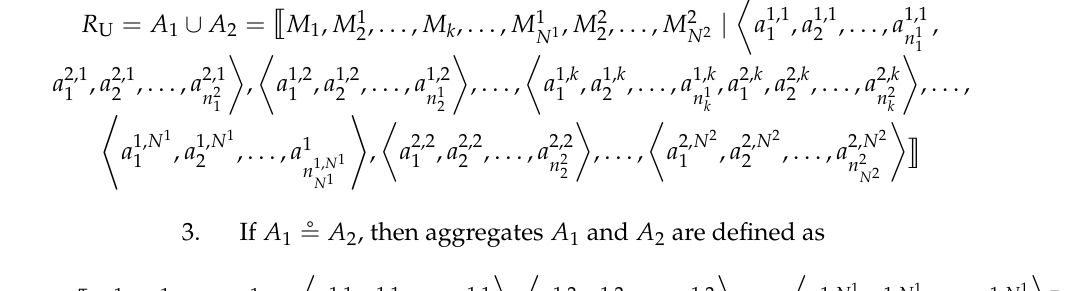
Figure 1. An example of two compatible aggregates. Figure 4. An example of two hiddenly compatible aggregates.